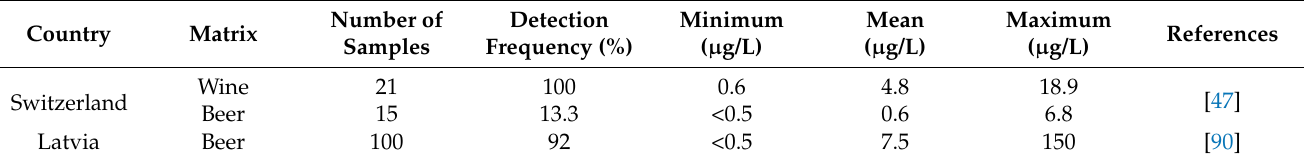
Table 11. Occurrence of glyphosate in alcoholic